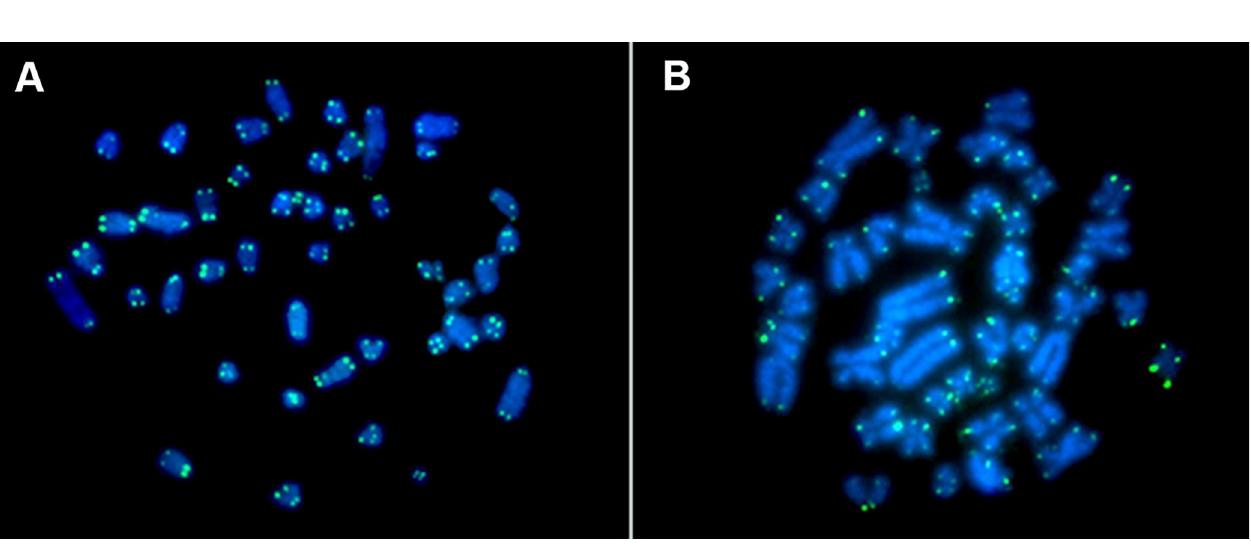
PLOS ONE | https://doi.org/10.1371/journal.pone.0258474 October 11,